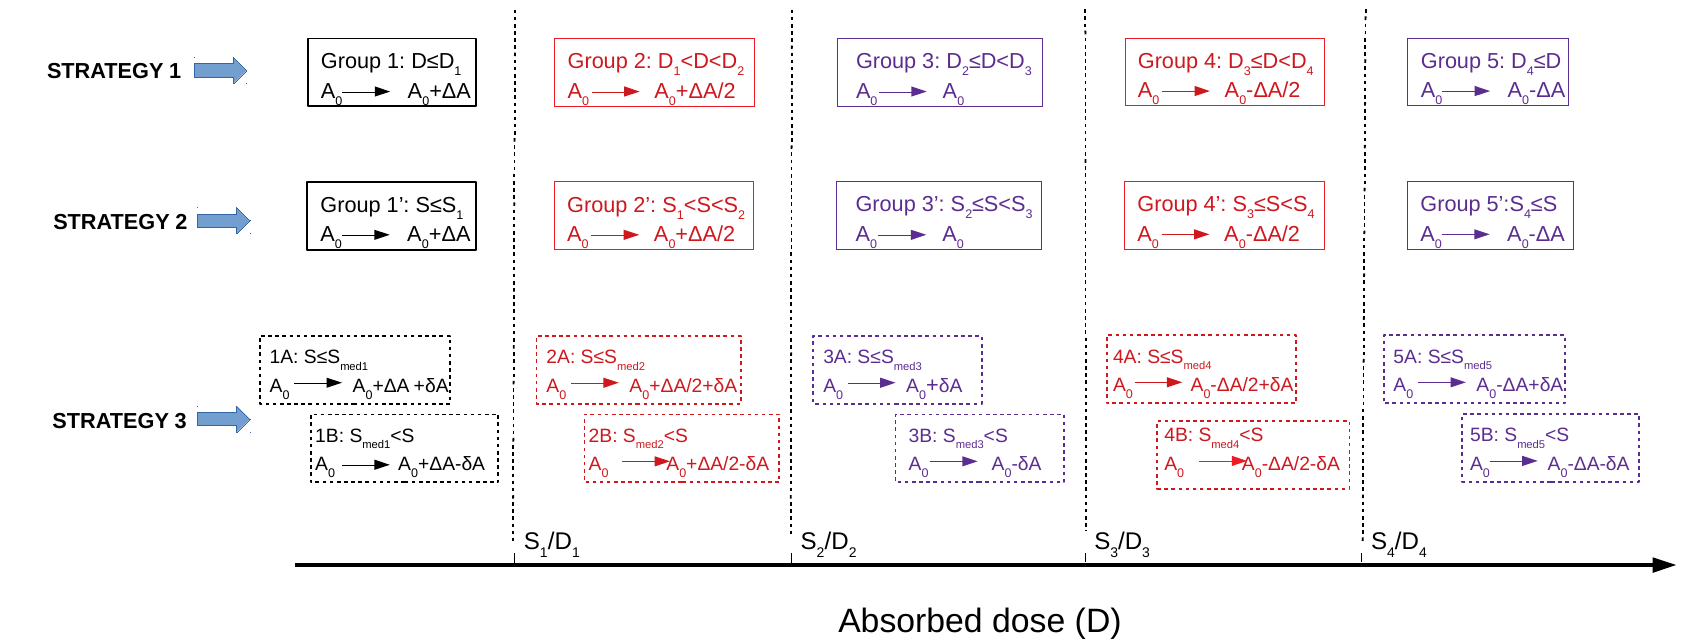
Figure 2. Sketch of stratification and therapy individualization. Three strategies are presented. In Strategy 1, simulated patients are split into 5 groups according to absorbed dose in the tumor. Dose thresholds ( D 1 , D 2 , D 3 , D 4 ) are defined to have 1/5 of patients in each group. Strategy 2 is similar, but patients are stratified into five groups according to their radiosensitivity (characterized through the parameter of accumulation of sub-lethal damage, b ). Sensitivity thresholds ( S 1 , S 2 , S 3 , S 4 ) are defined to have 1/5 of patients in each group. Strategy 3 is a combination of both previous strategies: the same five groups of Strategy 1 are created (according to absorbed dose in the tumor), but each of them is further split into two subgroups (A and B) according to the radiosensitivity of tumor cells, as in Strategy 2. The threshold to split each group is defined as the median of the group, in order to have 1/2 of patients in subgroup A and subgroup B. For individualization, administration of 131 I activity A is prescribed differently in each group (Strategy 1 and Strategy 2) or subgroup (Strategy 3), as a function of activity perturbations ∆ A and δ A . Individualized activities are defined in such a way to verify that the mean injected activity in the whole cohort does not change, no matter what individualization strategy is